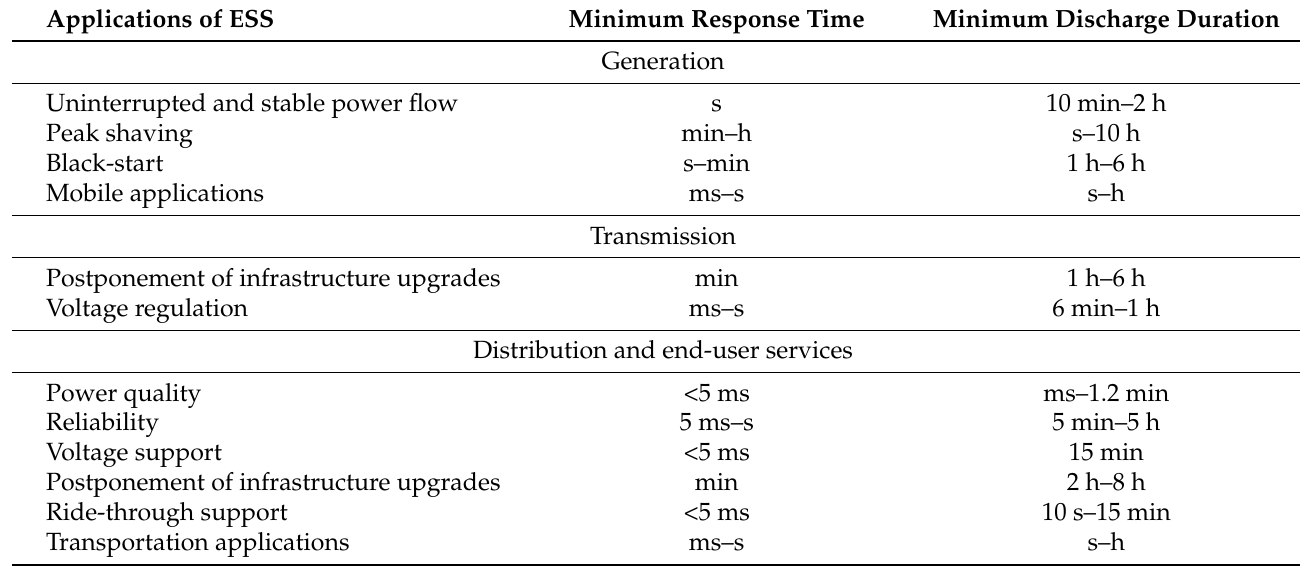
Table 1. The minimum response time and discharge time of the applications of the